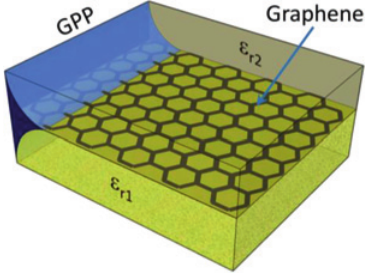
Figure 1: Graphene plasmon polaritons. Schematic illustration of the GPP field-intensity distribution (shown in blue) for a continuous sheet of graphene embedded within two homogeneous dielectric media of permittivity ε r1 and ε r2